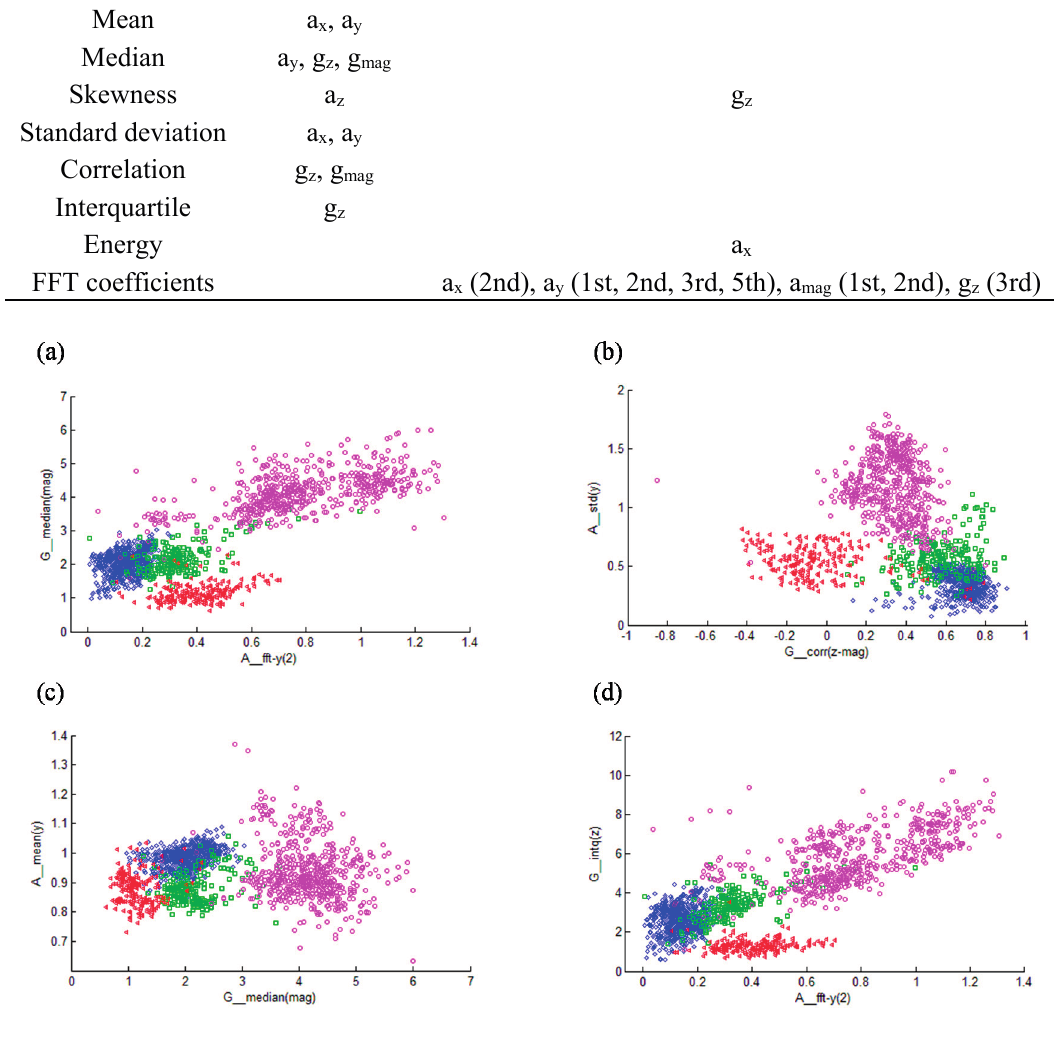
Figure 4. An example of activity clusters’ distribution over features selected by SVM, where pink, red, green and blue colors represent running, SA, SD and walking activities, respectively. ( a – d ) refer to different combinations of feature